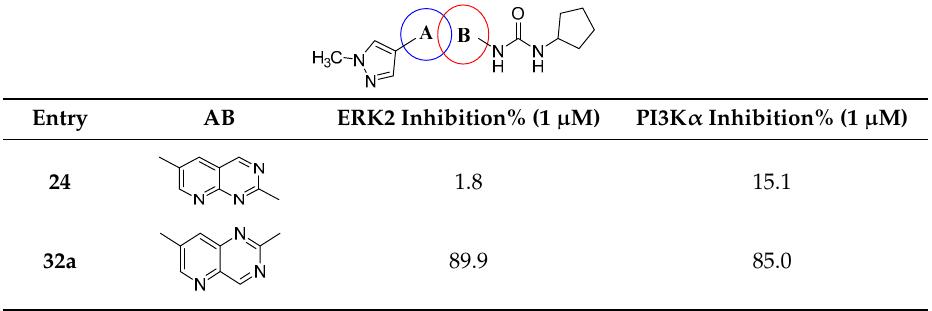
Table 2. In vitro ERK 2 and PI3K α inhibitory activities of compounds 24 and 32a .